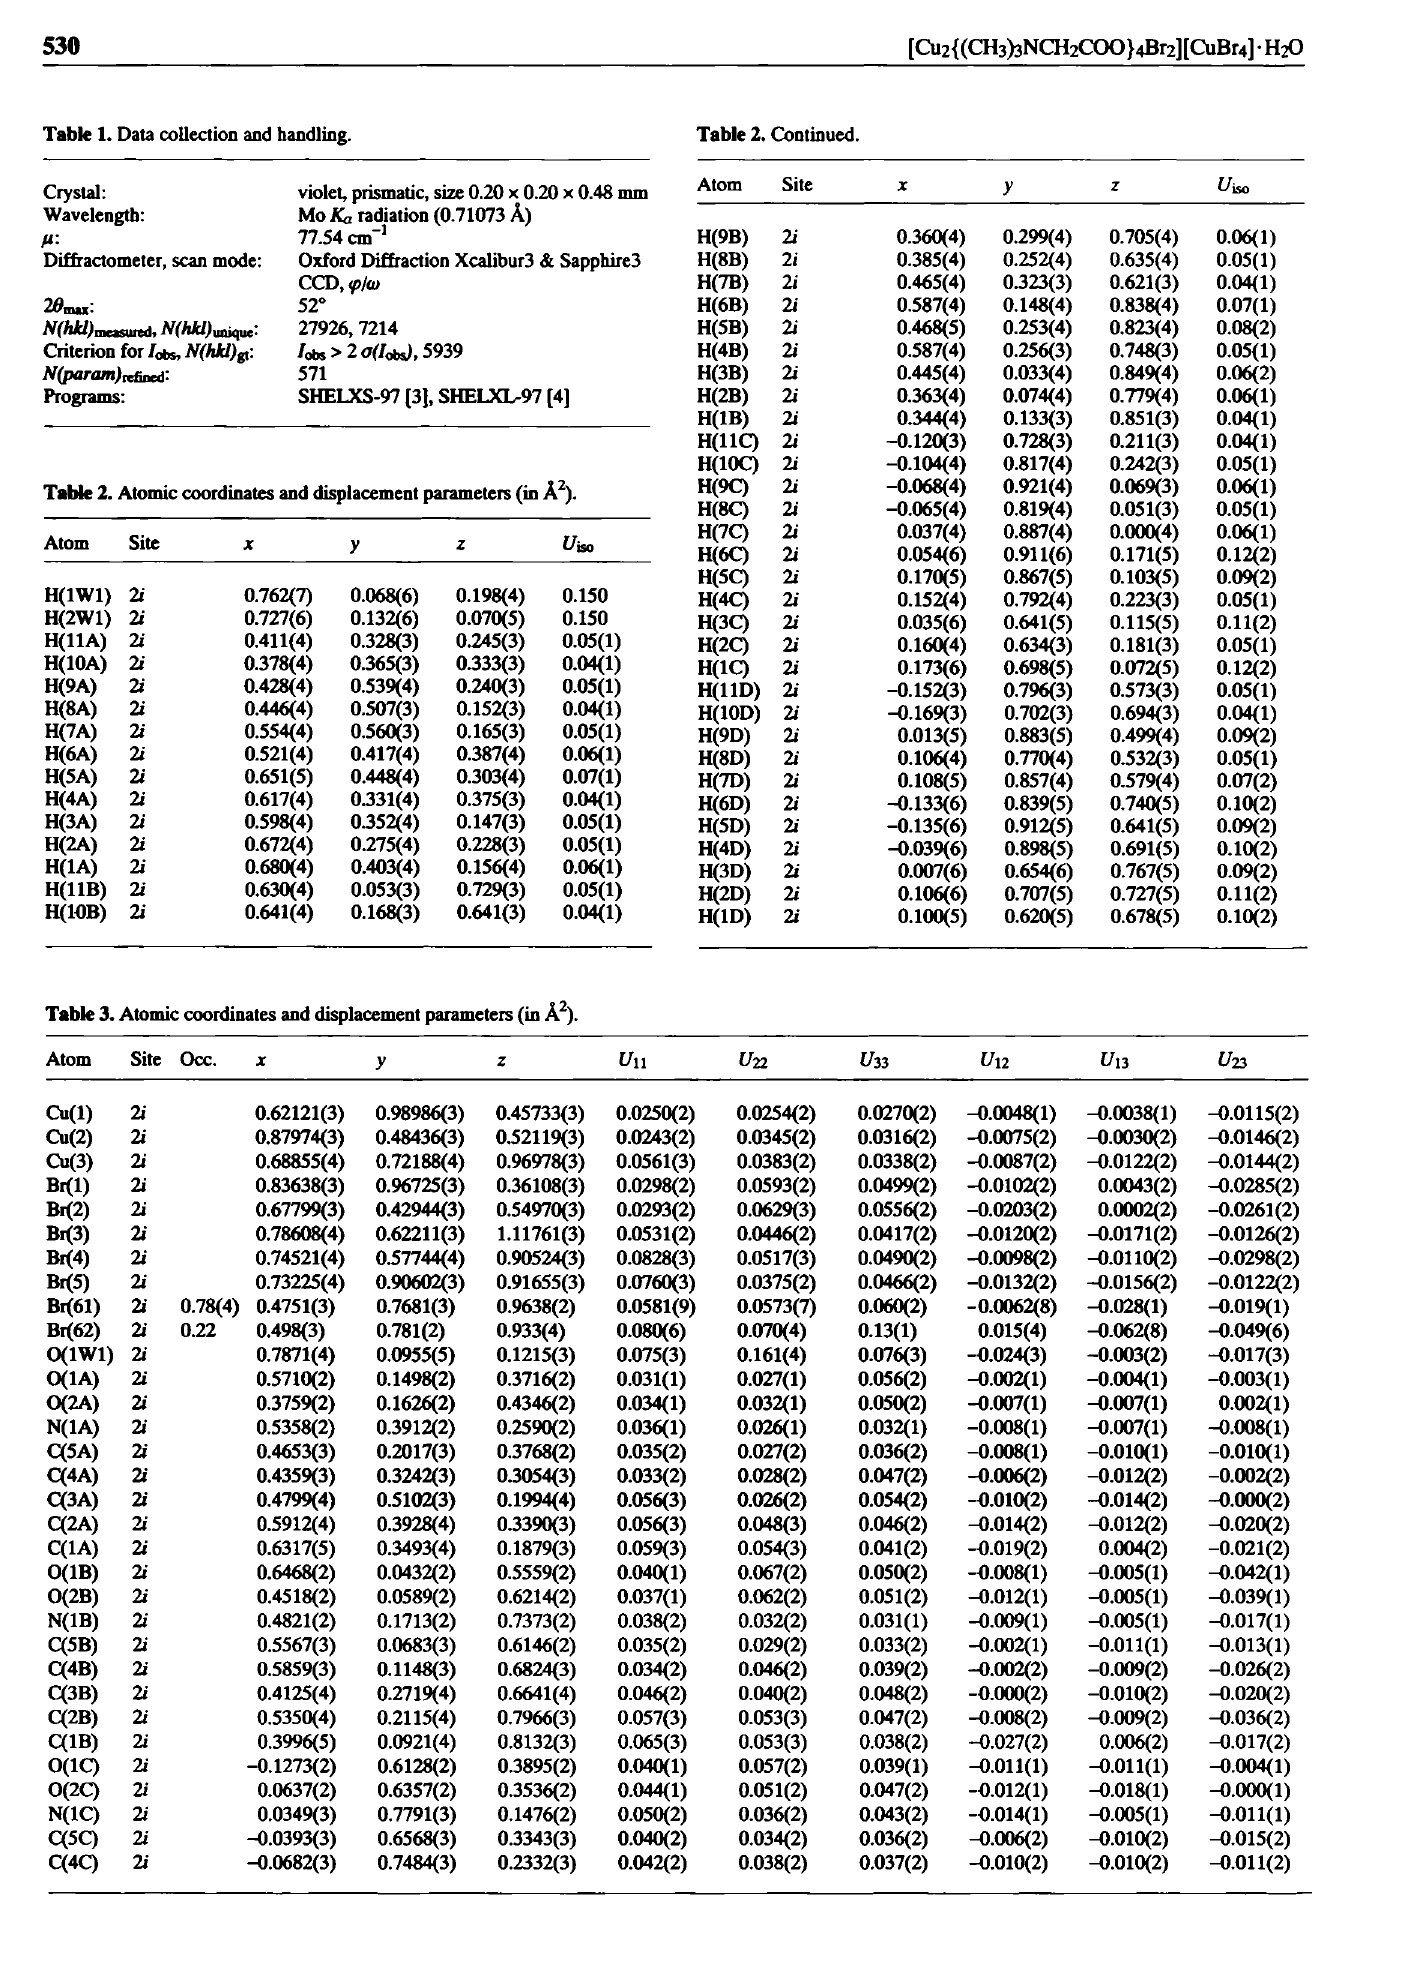
Table 1. Data collection and handling. Table 2. Continued.